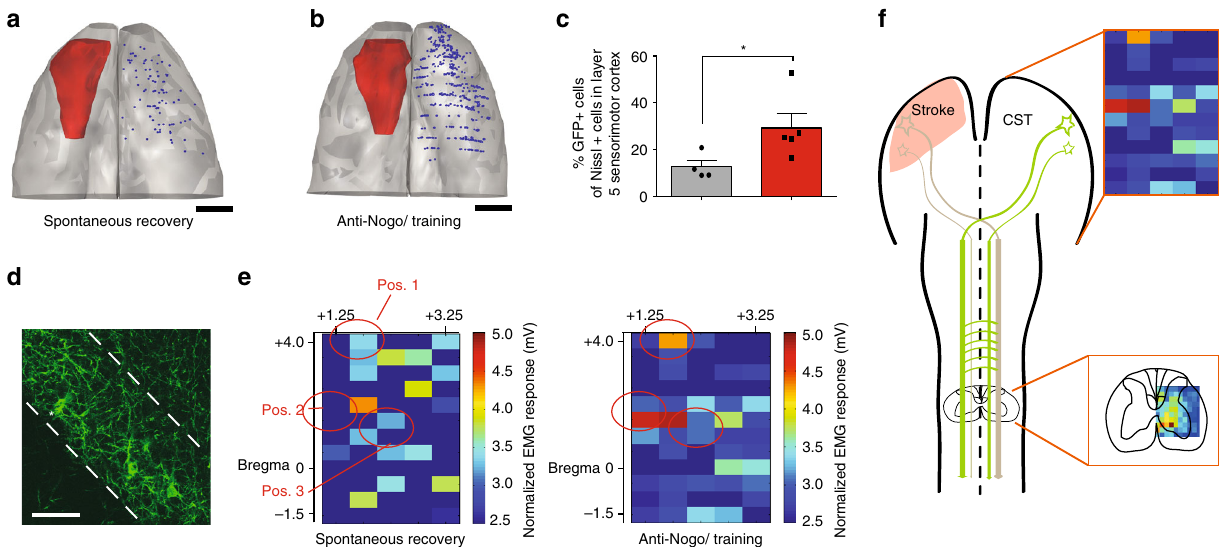
Fig. 7 In animals with excellent recovery more contralesional corticospinal neurons project to the stroke denervated cervical hemi-cord and are clustered in M1 and premotor cortex. a , b Representative neurolucida reconstructions of localization and amount of corticospinal neurons in layer 5 expressing GFP, induced by the retrograde transport of AAV2.9-CamKII-Cre from the stroke denervated hemi-cord (s. Fig. 5b) in an animal of the “ Spontaneous recovery ” group ( a ) and one of the “ Anti-Nogo/Training ” group ( b ), scale bars = 2 mm. c GFP-positive neurons as percent of Nissl-positive cells in layer 5 of the premotor and motor cortex (4.2 mm ± 500 µ m anterior and 0.67mm ± 300 µ m posterior to bregma): Signi fi cant more GFP-positive cells were found in anti-Nogo animals (red) compared to animals with spontaneous recovery (gray column, p > 0.05, paired t -test, with post hoc Bonferroni). d Examples of GFP-positive corticospinal-projecting pyramidal cells in layer 5 in the sensorimotor cortex (scale bar = 40 μ m). e Intracortical microstimulation reveals “ hot spots ” in M1 and premotor cortex (M2) for circuits that evoke ipsilateral EMG responses from the contralesional M1 and M2 in “ Anti-Nogo/Training ” animals ( n = 4). In contrast, in the “ Spontaneous recovery ” group ( n = 3), only a diffuse cortical pattern for the evocation of EMG responses in the stroke- impaired forelimb was found. Heat maps of the cortical stimulation grid (60 stimulation points, 80 μ A, + 4 to − 1.5 mm AP and 1.25 to 3.25 mm ML relative to bregma) are shown whereby each stimulation point is color coded with the mean value of EMG response in mV (mean of EMG amplitudes in wrist, elbow, and shoulder) for the stroke-impaired forelimb. The red circles indicate the previous positions of the three optical implants. EMG responses are signi fi cantly pronounced in “ Anti-Nogo/Training ” animals at Pos. 2 compared to the “ Spontaneous recovery ” group (Pos. 1 p = 0.149; Pos. 2 p = 0.0013; Pos. 3 p = > 0.99, Mann – Whitney test). f Scheme: Our results suggest not only localized functional reorganization in the contralesional sensorimotor cortex, but also sprouting of midline crossing and ipsilaterally projecting CST fi bers in lamina 6/7 of the stroke denervated cervical hemi-cord. Asterisks indicate signi fi cances: * p < in the “ Anti-Nogo/Training ” animals (Fig. 4a, b), we identi fi ed a signi fi cantly higher number of GFP-positive neurons in the contralesional motor cortex for the “ Anti-Nogo/Training ” group compared to the “ Spontaneous recovery ” animals group (Fig. 7a – c, for C p < 0.05, paired t -test, with post hoc Bonferroni). Finally, we used intracortical microstimulation (ICMS) to con fi rm the localization of corticospinal neurons projecting from the contralesional hemisphere to the ipsilateral stroke denervated forelimb hemi-cord. We used a 5 × 12 point stimulation grid (positioned at +4 to − 1.5 mm anterio-posterior and 1.25 – 3.75 mm medio-lateral coordinates relative to bregma) and electromyogram (EMG) recordings of wrist, elbow, and shoulder muscles of the impaired paw as readouts (Fig. 7e). We found a diffuse response pattern upon cortical electrical stimulation all over the contralesional pre- and primary motor cortex in animals without rehabilitative treatment (Fig. 7e, “ Spontaneous recovery ” group). In contrast, clear cortical “ hot spots ” in M1 and the rostral forelimb fi eld that elicited motor responses in the formerly impaired forelimb, in particular for wrist and elbow, were detectable in the animals of the “ Anti-Nogo/Training ” group (Fig. 7e and Supplementary Fig. 6), indicating a highly localized representation of the reorganized corticospinal neurons project- ing to the ipsilateral forelimb. The M1 ipsilateral forelimb “ hotspot ” identi fi ed by ICMS corresponded well to the position 2 (M1) of the optical implants for the silencing experiments described above. The EMG responses evoked around position 2 were signi fi cantly higher in “ Anti-Nogo/Training ” animals than